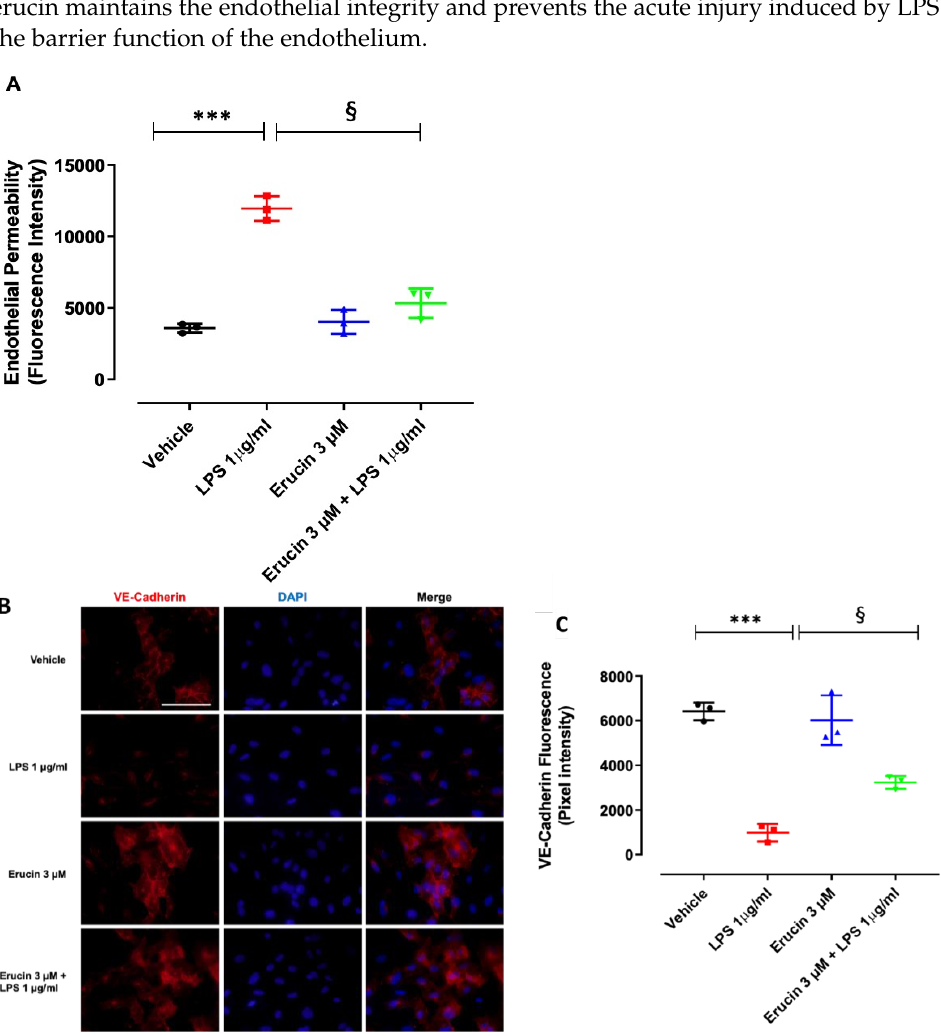
2.3. Effect of Erucin on Endothelial Permeability and VE-Cadherin Changes in Response to LPS